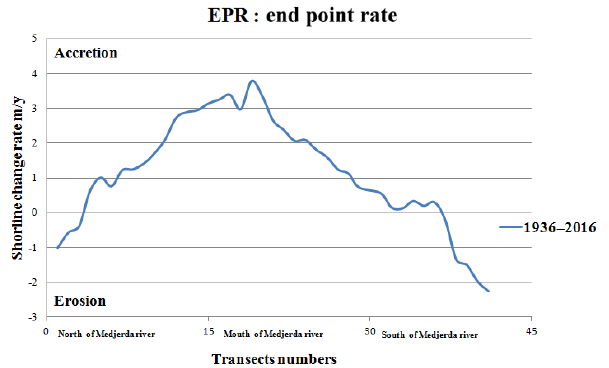
Figure 8. The rates of shoreline changes (EPR) in new mouth of Medjerda river.